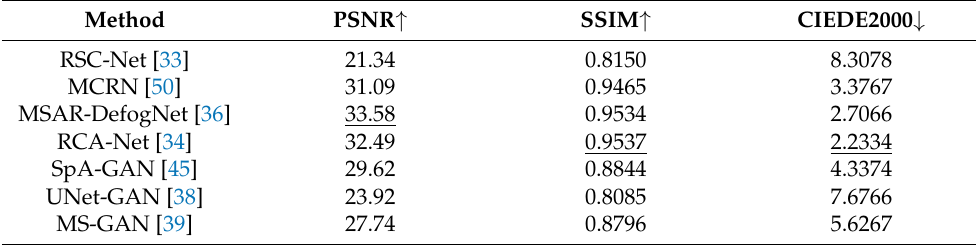
Table 7. Quantitative evaluations on the RICE1 dataset. The bold and underlined text indicates the best and second-best performance, respectively. The ↑ symbol indicates that larger values are better, while ↓ indicates that smaller values are